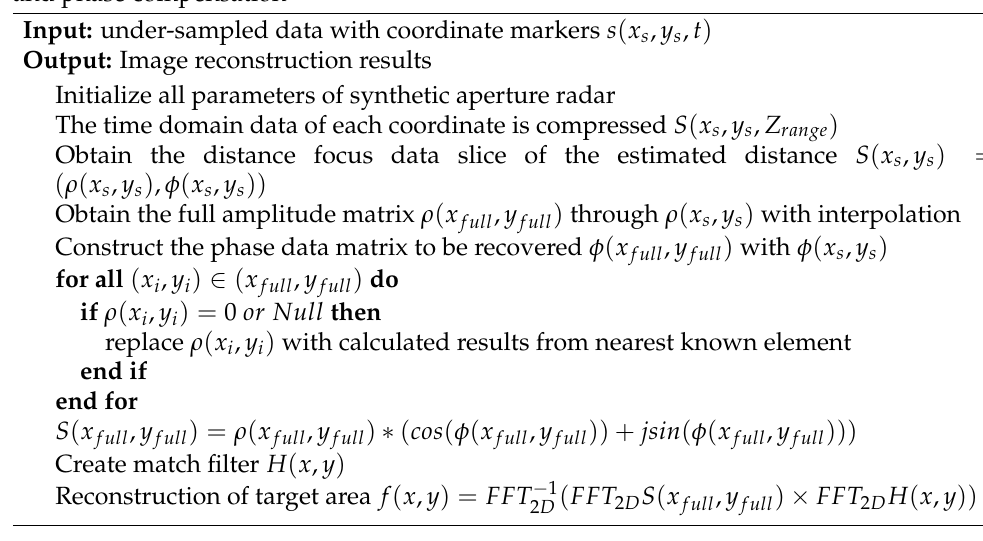
Figure 4. Diagram of a row of distance compressed data in the x direction. Algorithm 1 Spatial under-sampling image reconstruction method based on amplitude and phase